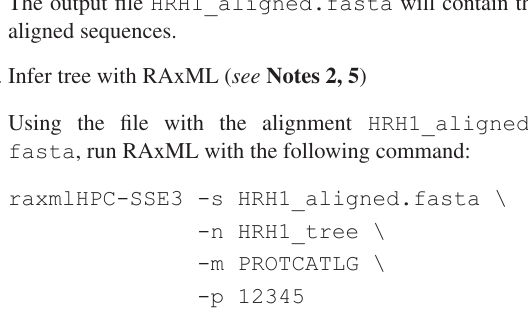
Protocol 2: Measuring site-specific